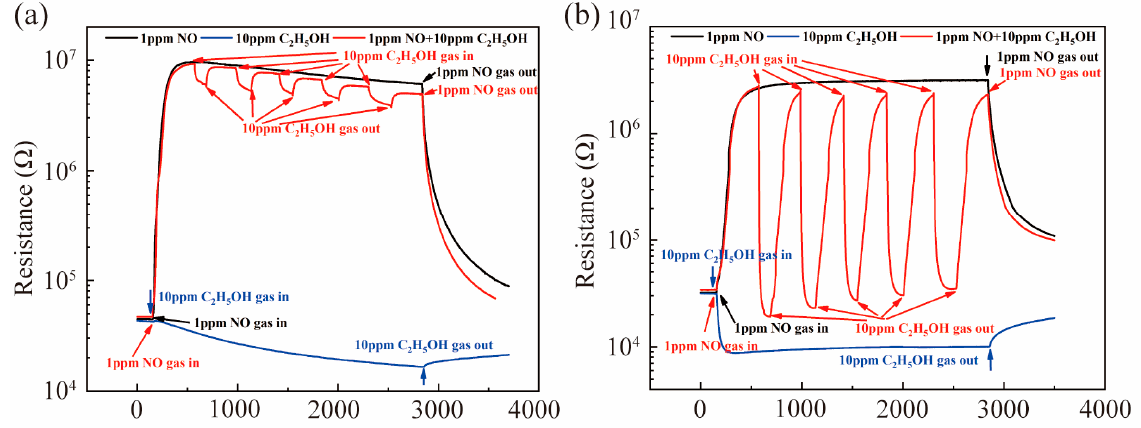
at 150 °C. at 150 ◦ C.